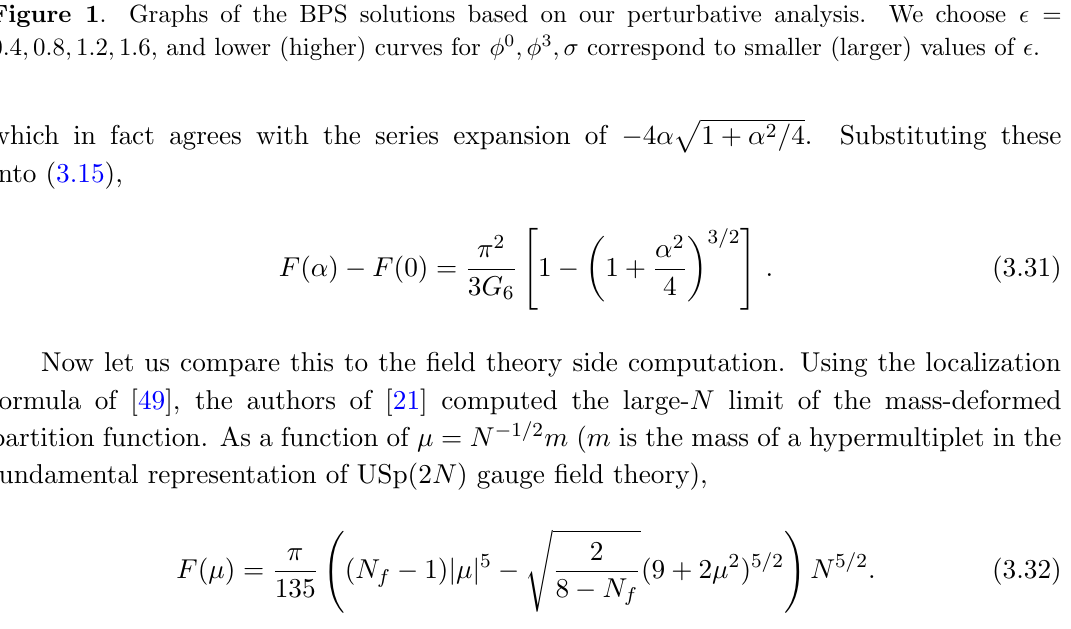
p 1 + (cid:11) 2 = 4. Substituting these